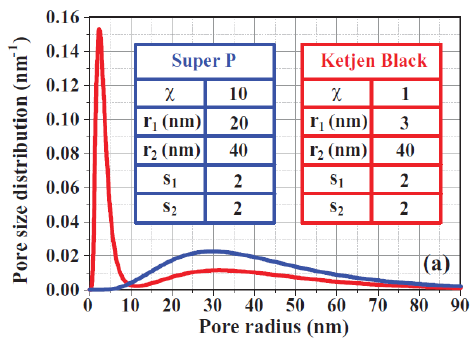
Figure 15. Pore size distribution of Super P and Ketjen Black carbons, with parameters in the bimodal distribution function. Republished from Xue et al. [23] with permission of The Electrochemical Society, conveyed through Copyright Clearance Center, Inc.